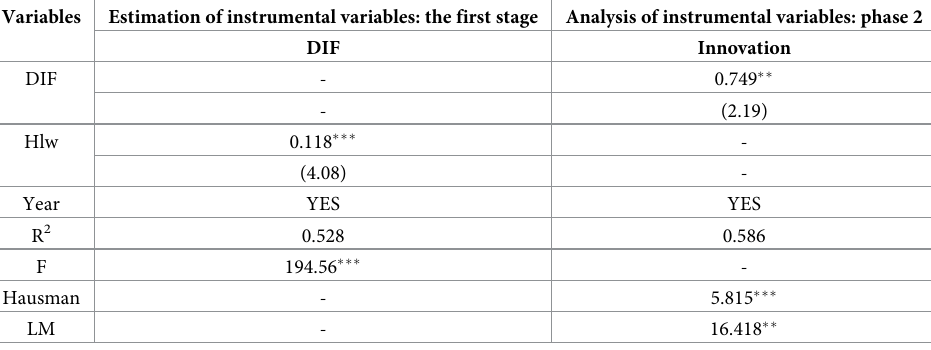
Table 6. Endogeneity treatment: Two-stage least squares instrumental variables method.